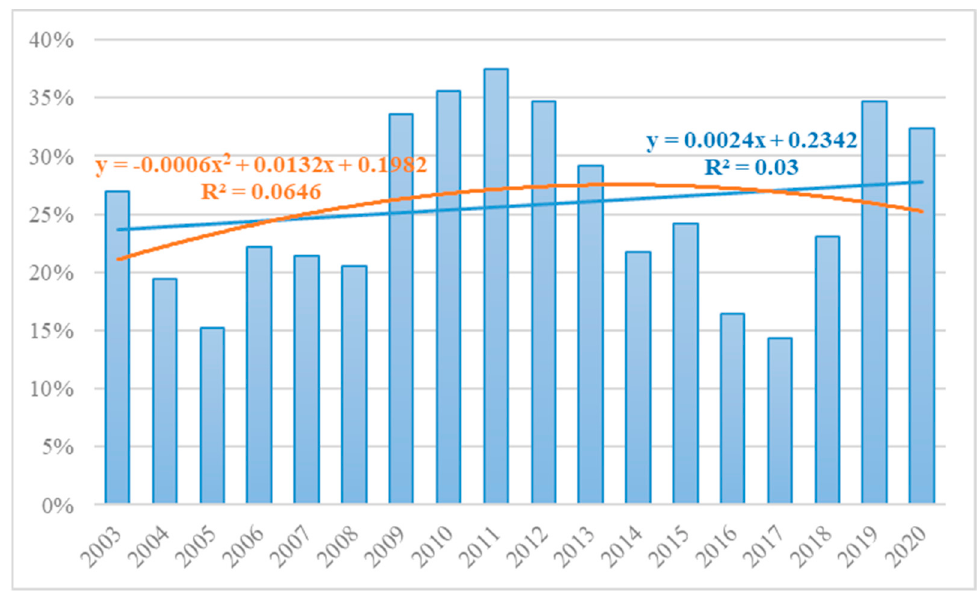
Figure 7. Ratio of liabilities to the annual budget revenues for 2003–2020 (in %) for the city of Katowice. Source: own elaboration.